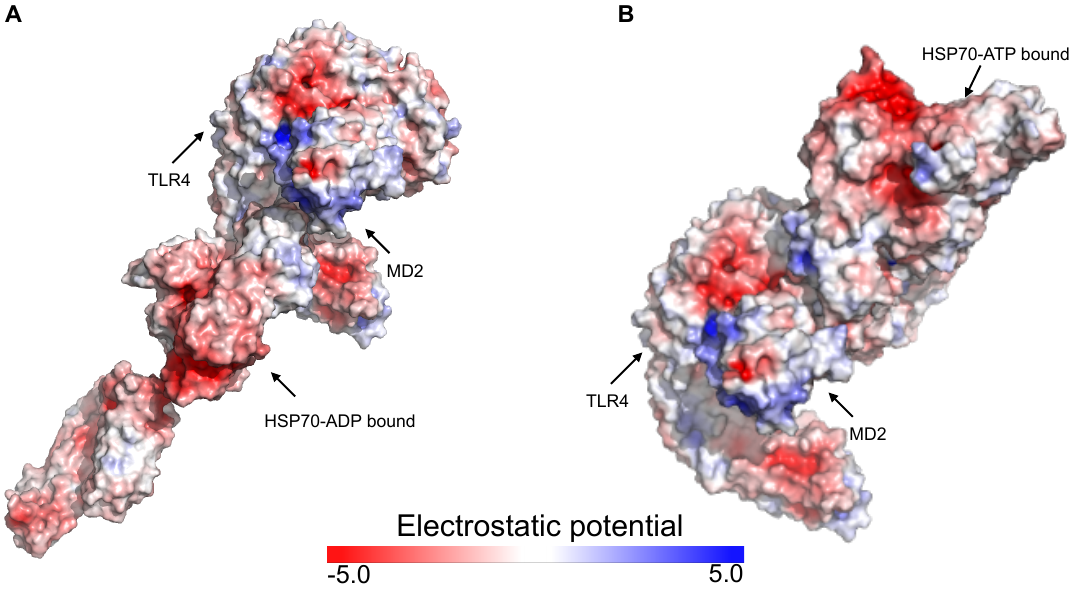
Figure 3. Electrostatic analysis of the interaction of the highest ranked docking conformation generated by ClusPro 2.0. ( A ) TLR4/MD2 vs. HSP70-ADP and ( B ) TLR4/MD2 vs. HSP70-ATP. The electrostatic potential of the highest ranked docking conformation for each condition was computed using the Adaptive Poisson-Boltzmann Solver (APBS) electrostatics plugin in the software PyMol (version 2.2.0) and it is shown in a red (negative) to blue (positive)